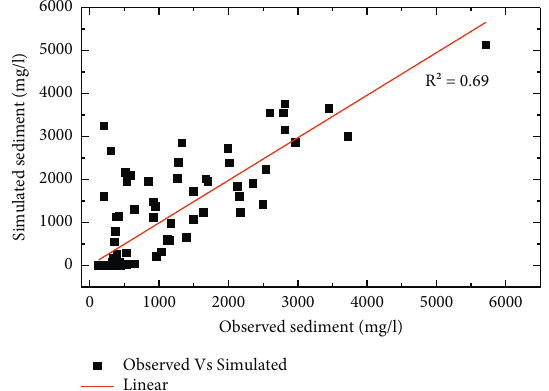
Figure 6: Observed versus simulated